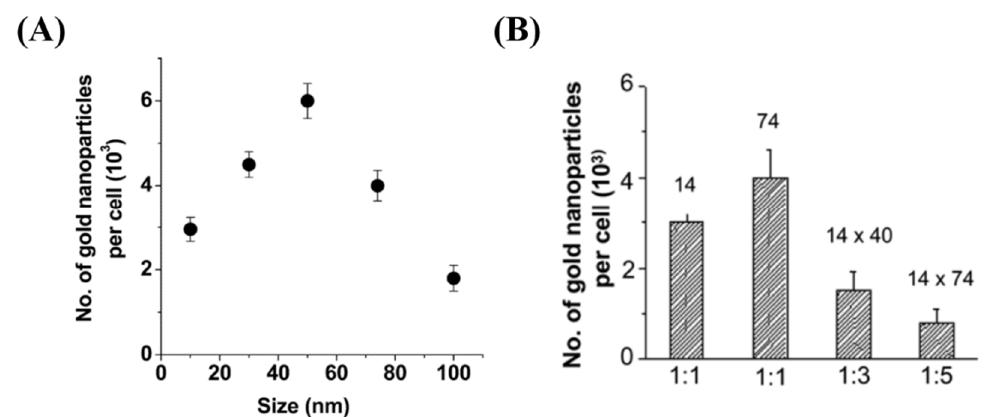
Figure 2. Uptake of GNP by receptor-mediated endocytosis. ( A , B ) Schematic illustrating pathway of citrate-capped GNP uptake into the cell. ( A ) Describes the entry and sort mechanism for a single NP and multiple NPs, while ( B ) describes the entire flow of internalization and excretion. Once GNPs are attached to the receptors on the surface of the cell, membrane invagination occurs followed by budding into the cell, forming a vesicle. The internalized GNPs are sorted inside the vesicle and eventually fuse with lysosomes. GNPs are then excreted out of the cell. ( C ) Transmission electron microscope images of rat kidney cells treated with three di ff erent sizes of GNPs. Scale bar is 2 µ m. Reproduced with permission [68,70]. Copyright American Chemical Society, 2009, 2011.